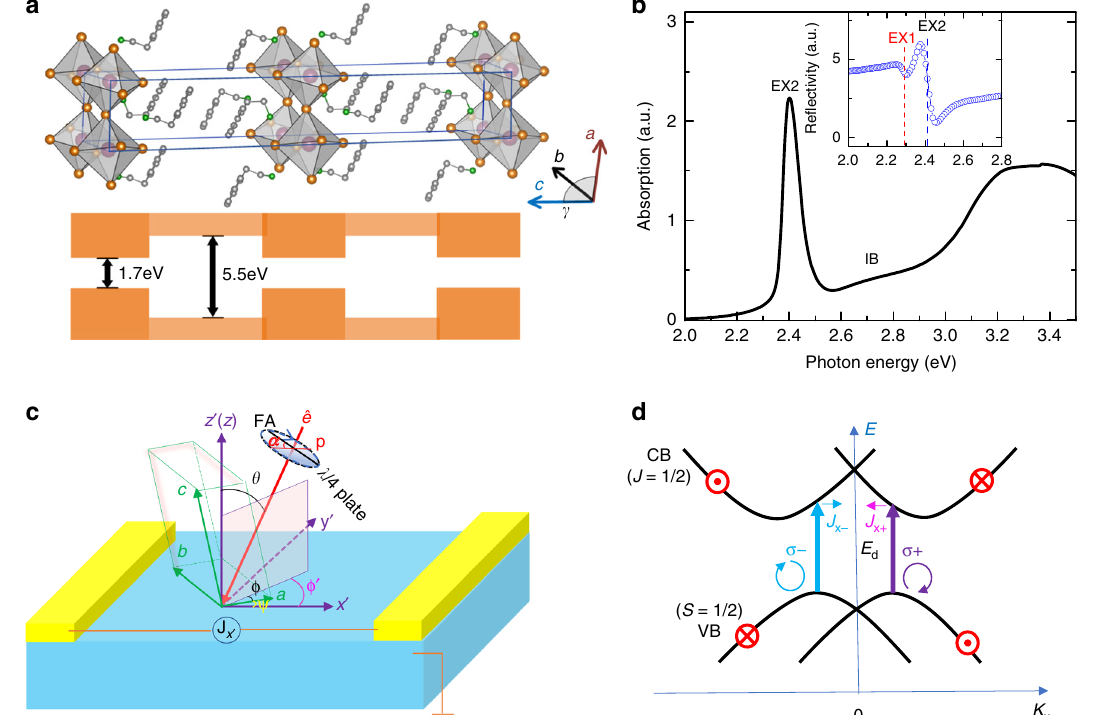
Fig. 1 Rashba splitting in 2D hybrid organic – inorganic perovskite (2D-PEPI) crystal. a Schematic of the 2D-PEPI structure with alternating (C 6 H 5 C 2 H 4 NH 3 + ) and [PbI 6 ] 4 − layers, which form natural multiple quantum wells (MQW), where the inorganic layer is the potential ‘ well ’ and organic layer is the potential ‘ wall ’ . The potential values were taken from ref. 22 The crystal structure is triclinic at room temperature, with growth direction along the c -axis. b Room temperature absorption (black line) spectrum of a thin fi lm 2D-PEPI where the exciton (EX) and interband (IB) transitions are denoted. The inset shows the re fl ectivity spectrum of a single crystal (blue symbol), having two different spectra features. The red(blue) broken line marks the two exciton species (EX1/EX2) observed in the 2D-PEPI crystal. c Experimental setup for measuring the PGE using λ /4 plate; the angles α , θ , and ϕ are denoted. x ’ indicates the current fl ow direction, making an angle, ψ with the crystal a -axis. d Schematic diagram of the continuum bands (VB and CB) having Rashba spin splitting, and related optical transitions with circular polarized light. The electron group velocity (and current) change polarity when the light changes helicity. E d is the direct energy difference between the CB and VB Dirac